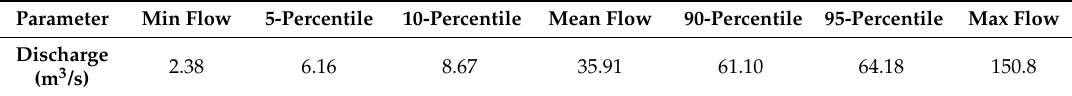
Table 2. Descriptive statistics of flow data from 2010 to 2017 downstream of Hol 1 hydropower